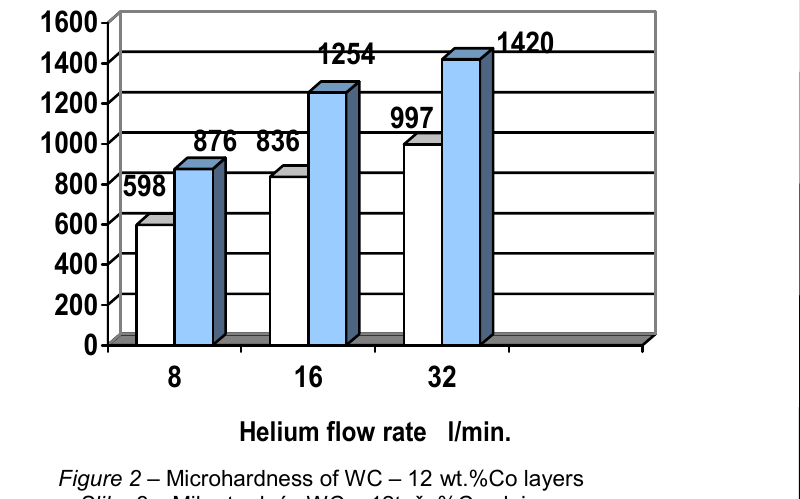
Figure 2 – Microhardness of WC – 12 wt.%Co layers Slika 2 – Mikrotvrdo ć a WC – 12tež. %Co